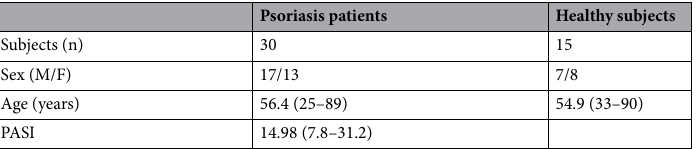
Table 1. Clinical characteristics of psoriasis patients and healthy subjects. Results are expressed as mean (min–max). M, male; F, female; PASI, psoriasis area and severity